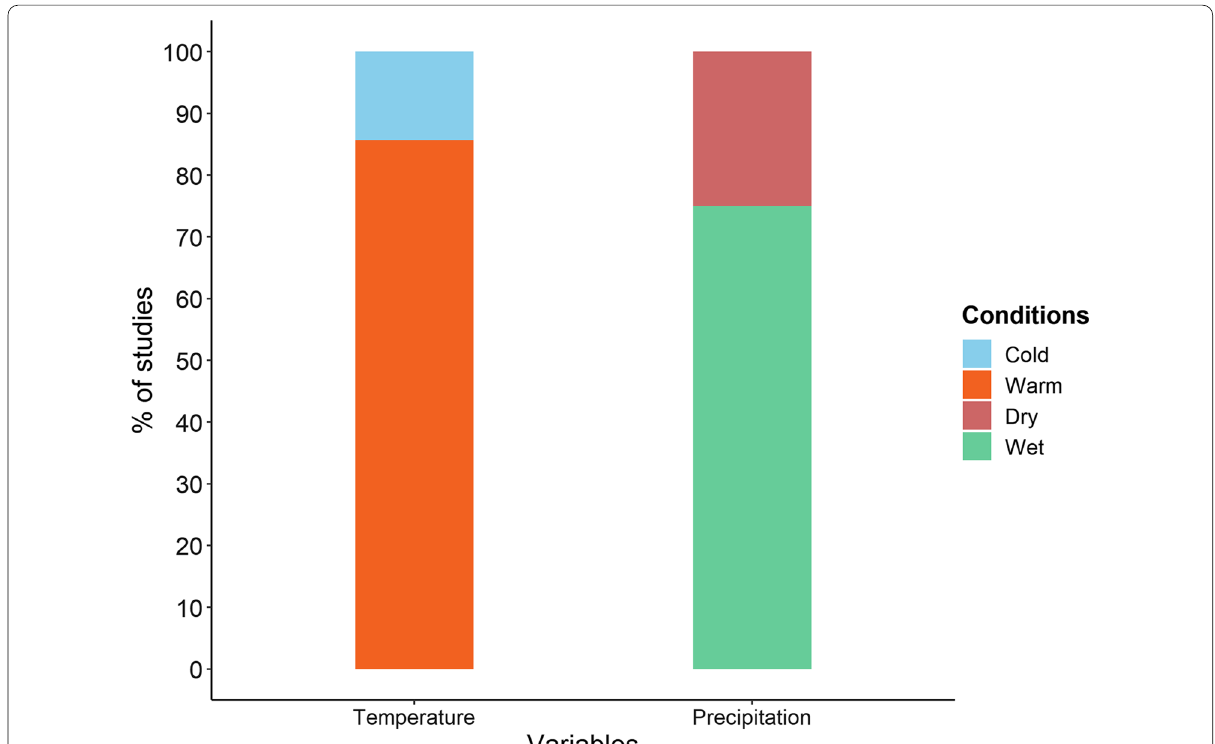
Fig. 2 Relationship of temperature and precipitation during the Eemian Interglacial Stage. The number of studies used for the warm/cold or wet/ dry conditions can be found in Table